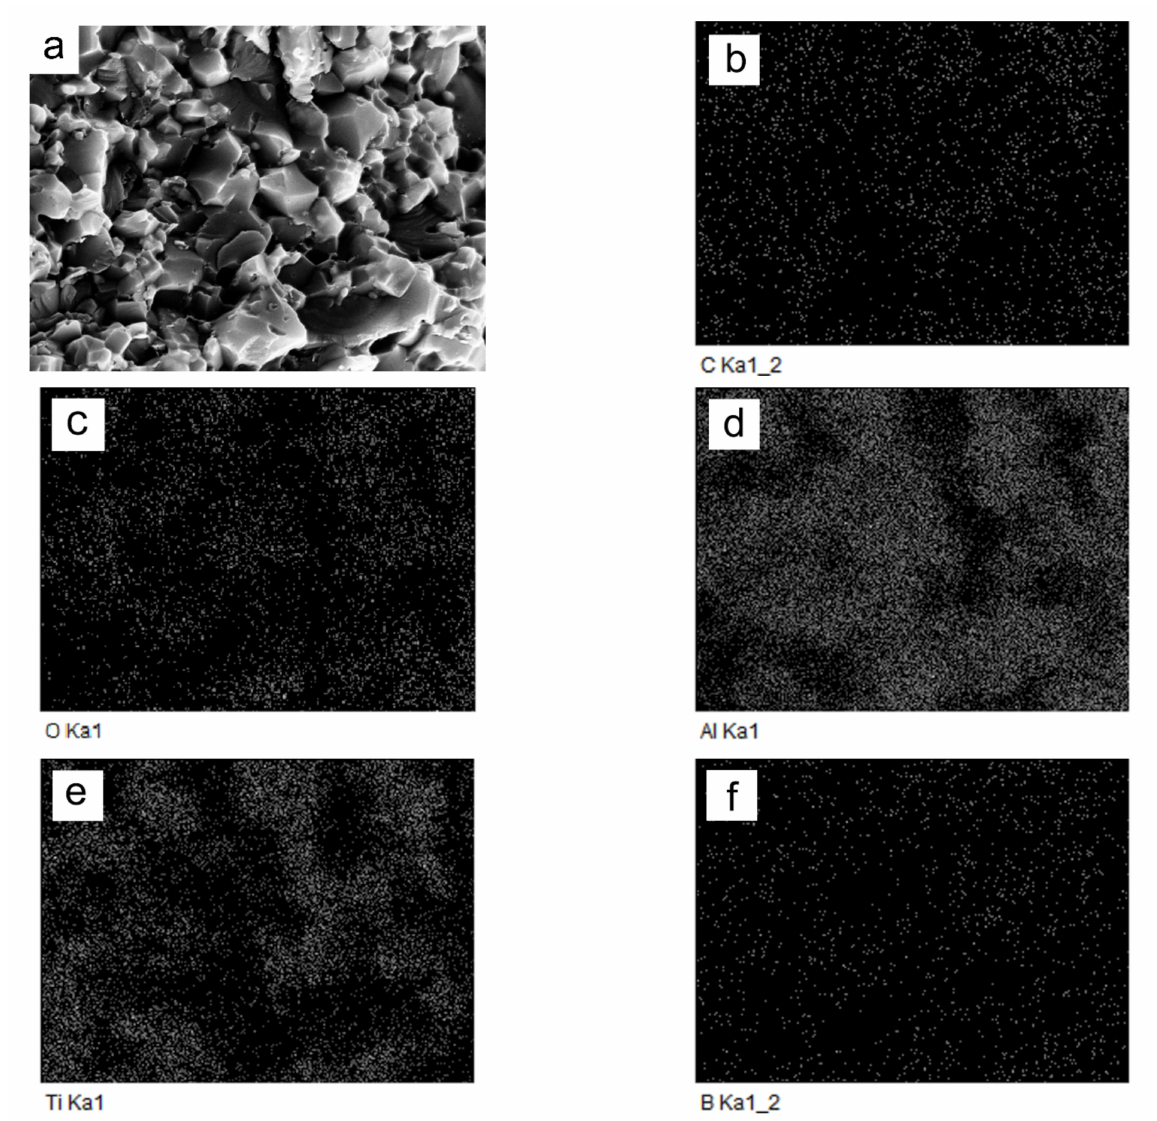
Figure 6. SEM micrographs ( a ) and EDS elemental distribution maps ( b – f ) of fracture surfaces of Al 2 O 3 /TiC/10 vol.% TiB 2 ceramic tool material.